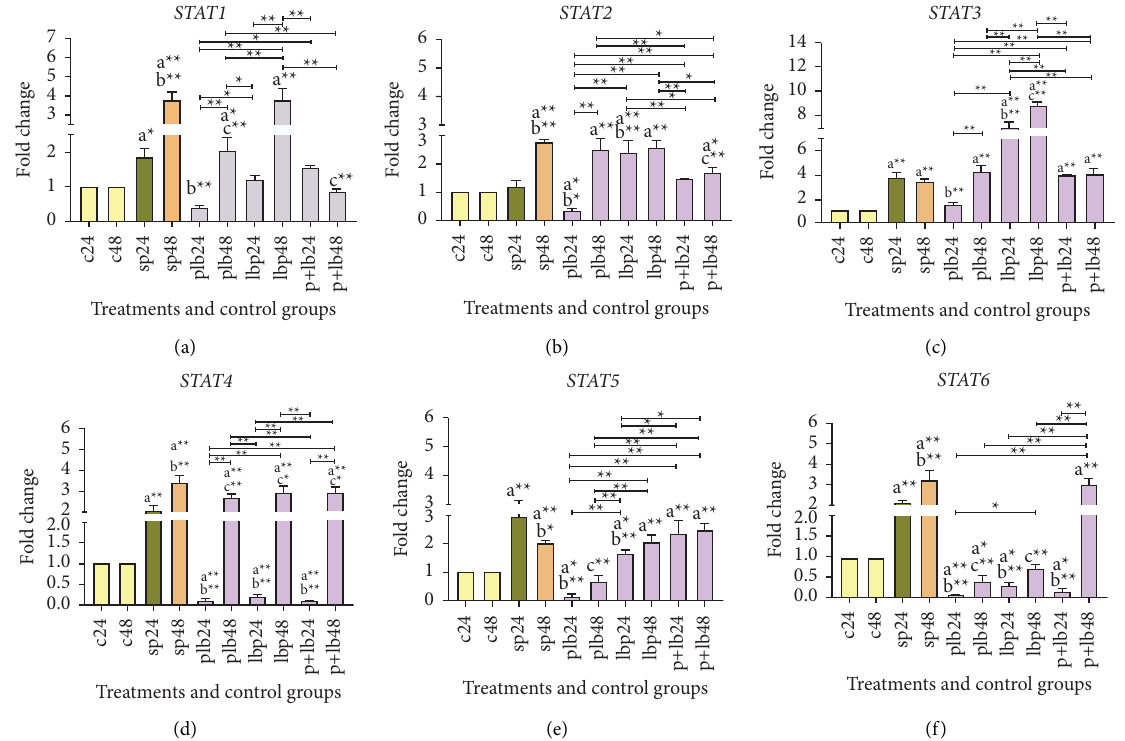
Figure 1: Relative gene expression (mean fold change) of (a) STAT1 , (b) STAT2 , (c) STAT3 , (d) STAT4 , (e) STAT5 , and (f) STAT6 in the diferent groups of treatments. Data were normalized with GAPDH . Data were represented as mean SD. Te number 24 and 48 refers to diferent time orders of HT-29 cell line treatments. (C) represents control; (P) represents pathogen; PLB represents frst pathogen and then Lactobacillus/Bifdobacterium; LBP represents frst Lactobacillus/Bifdobacterium and then sonicated pathogen; P+LB represents sonicated pathogen and then Lactobacillus/Bifdobacterium added simultaneously. Data were considered statistically signifcant when p < 0 . 05 ( ∗ p < 0 . 05, ∗∗ p < 0 . 001). Letter (a) indicates the relatedness between C24 and C48 with other treatments, letter (b) shows the relatedness between sp24 and other treatments, and letter (c) shows the relatedness between sp48 with other treatments. Te relatedness between other treatments is shown with